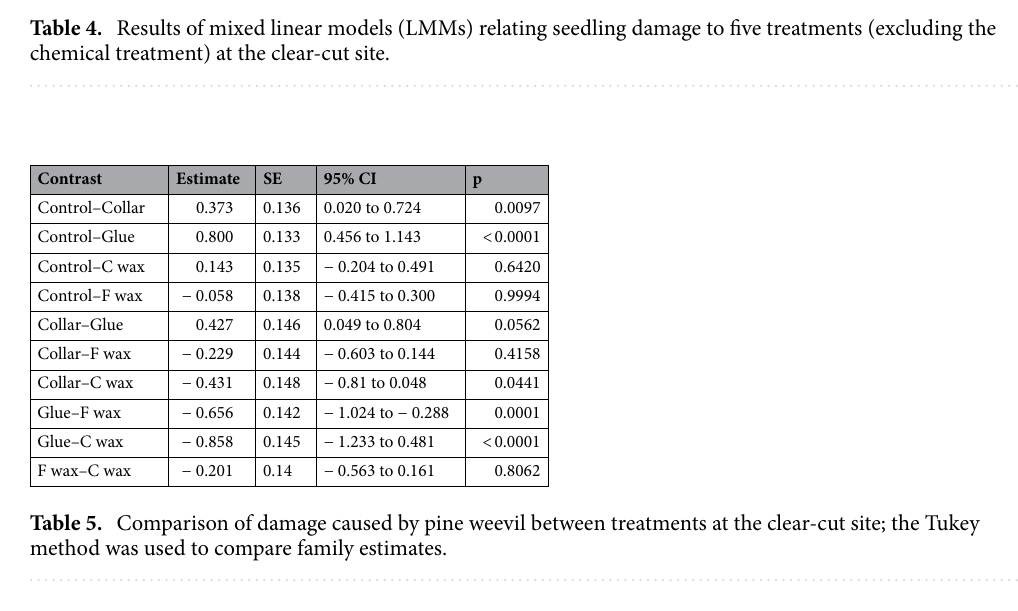
Table 5. Comparison of damage caused by pine weevil between treatments at the clear-cut site; the Tukey method was used to compare family estimates.